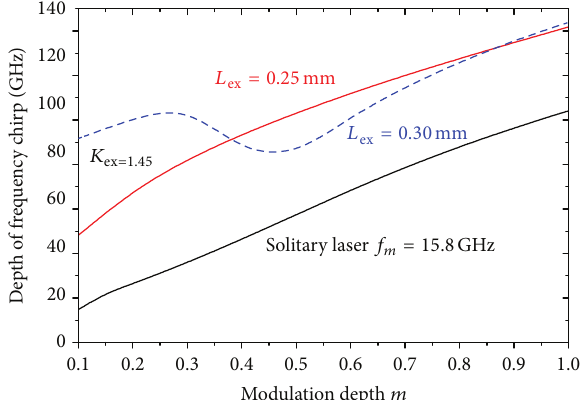
Figure 4: The frequency chirp Δ ] (𝑡) associated with intensity modulation as a function of the modulation depth for both the ultrahigh frequency modulated laser under OFB with 𝐿 and 0.30 mm and the solitary laser with 𝑓 𝑚 = 𝑓 𝑟